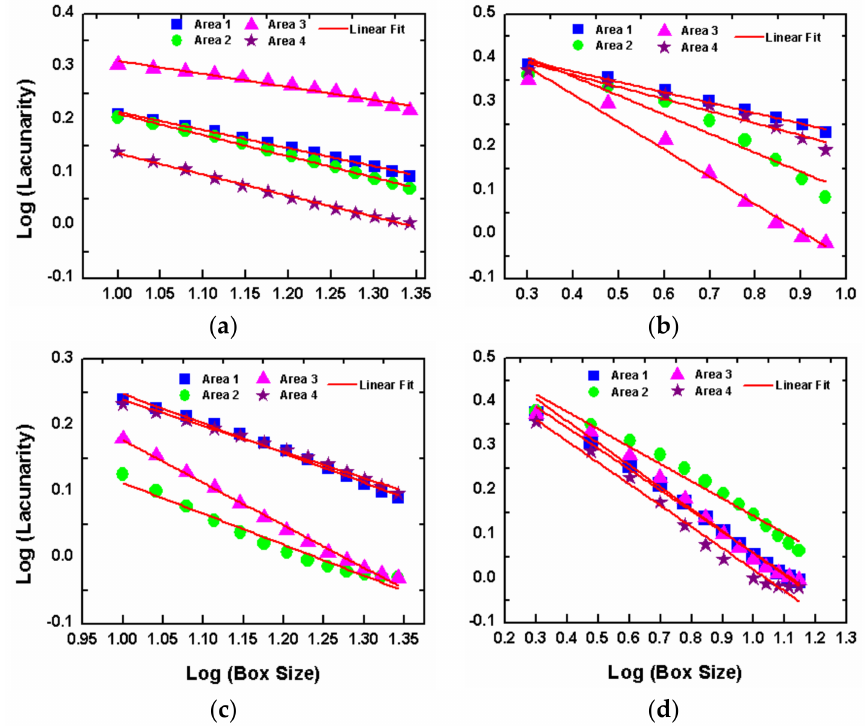
Figure 6. Lacunarity of the fractal region obtained from lacunarity distribution of the surface of layer-by-layer Cu/Cr thin films deposited on ( a ) BK7, ( b ) Si, ( c ) Glass, and ( d ) ITO